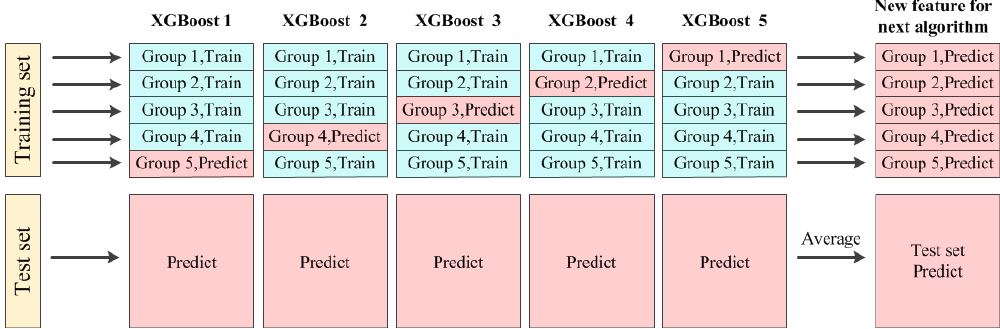
Figure 2. The principle of the k -fold cross-validation method.